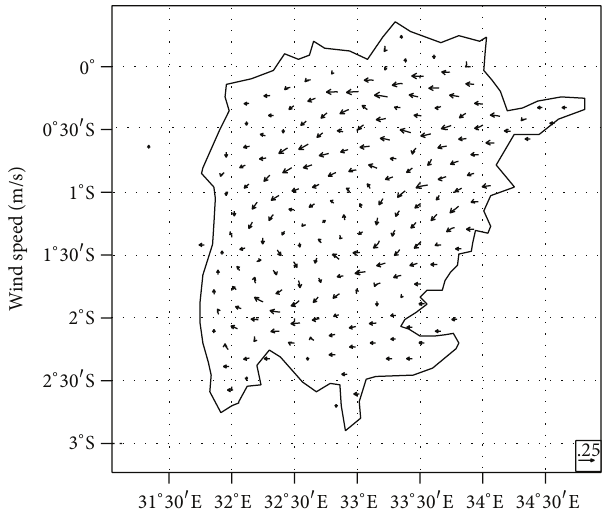
Figure 7: Simulated lake surface current (in m s −1 ) after two-month integration under the forcing of uniform wind